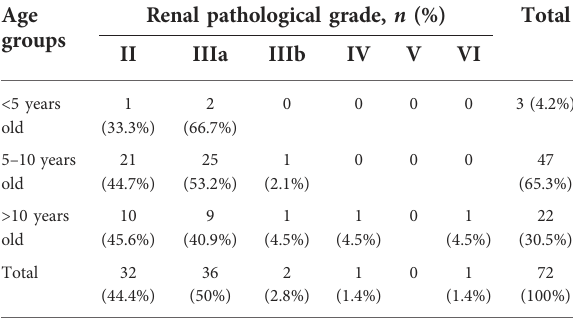
TABLE 2 Relationship between renal pathological grade and age